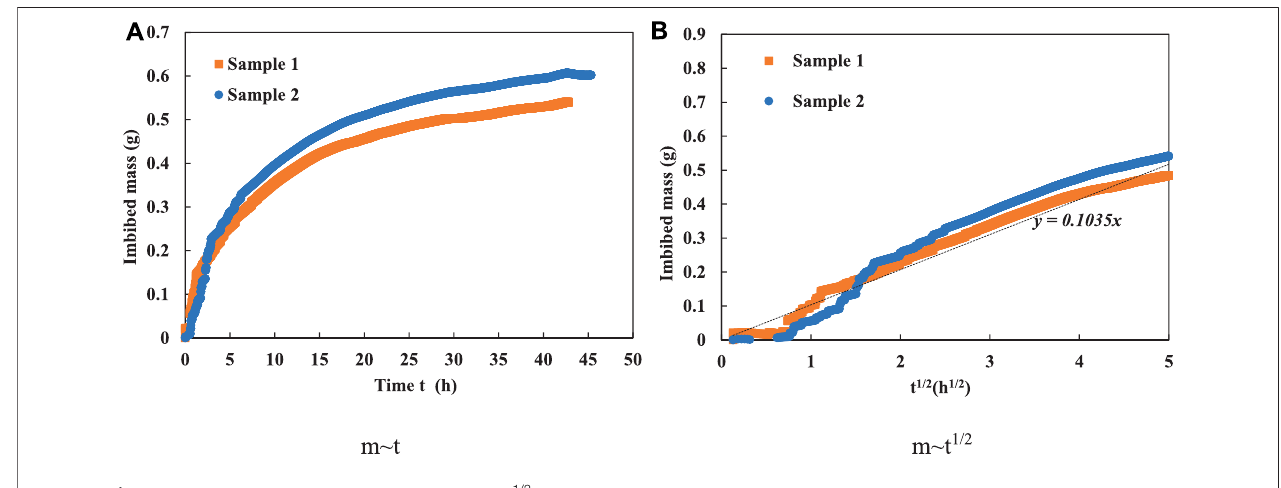
FIGURE 7 | Results of imbibition experiments. (A) m ∼ t. (B) m ∼ t 1/2 .